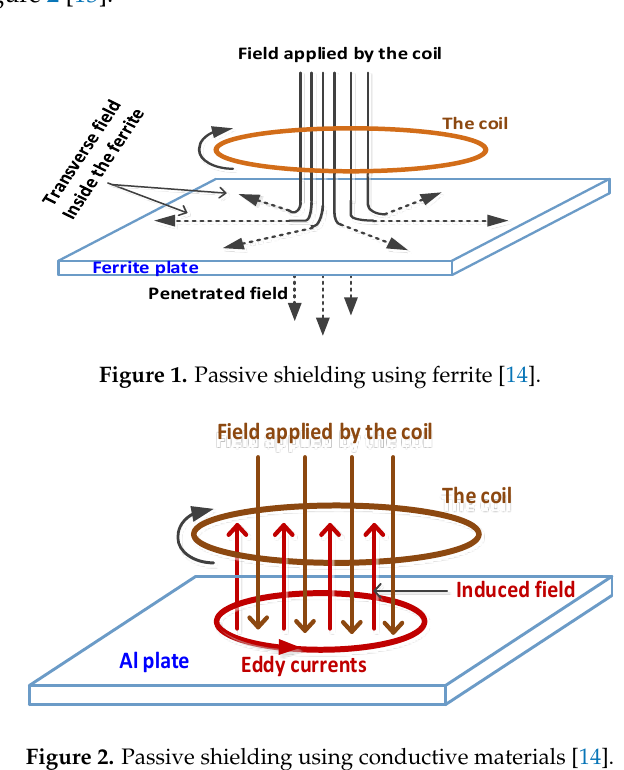
Figure 2. Passive shielding using conductive materials